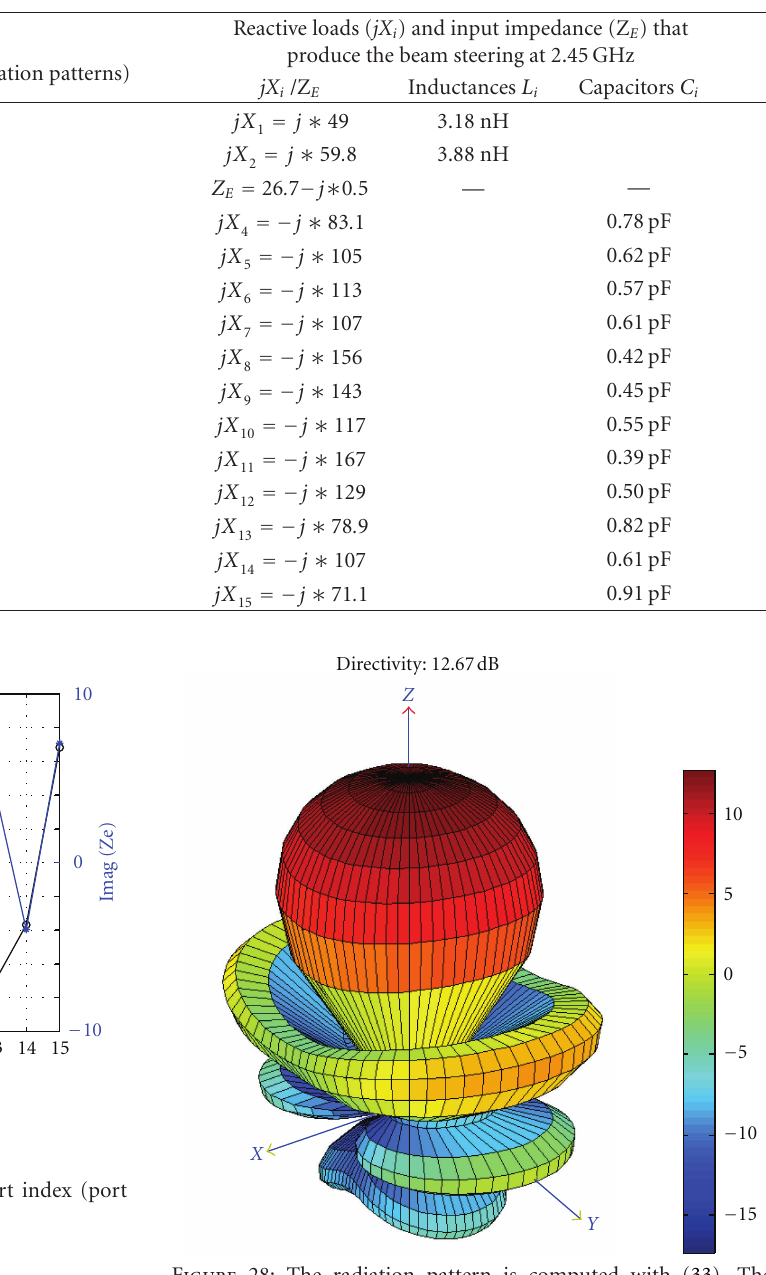
Figure 28: The radiation pattern is computed with (33). The complex weights and the reactive loads are reported in Table 5. The directivity is 12.67